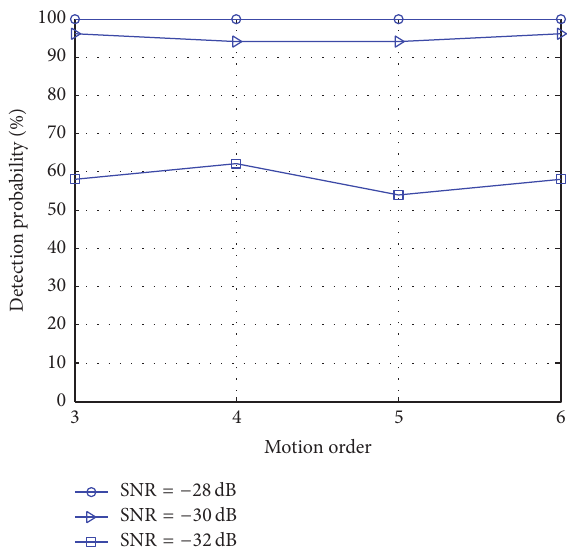
Figure 6: Detection probabilities of BMWDO-based GRFT with motion orders no less than 3. 𝑃 = 4 is preset when calculating BMWDO.